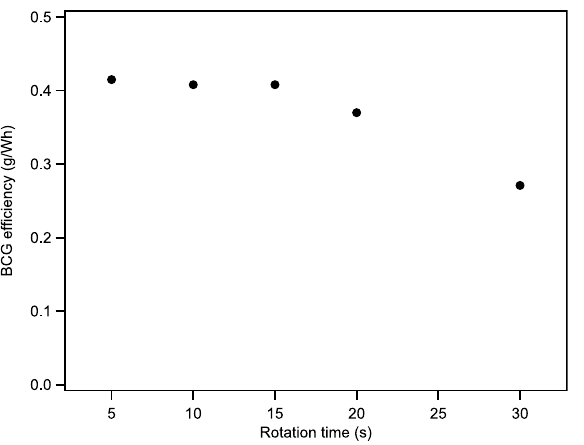
Figure 1. Graphite production irradiated energy efficiency plotted as a function of the duration of a full rotation of the pellet while irradiated at 200